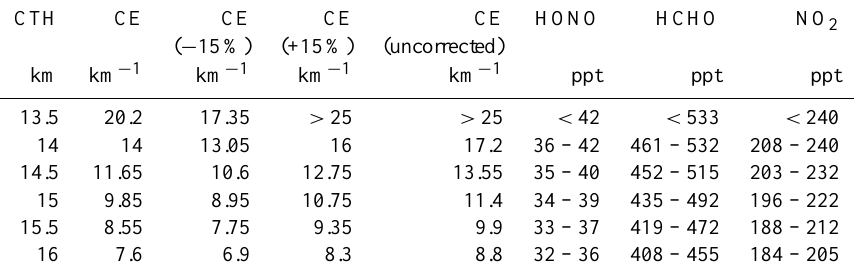
Table 6. Influence of the profile shape on the retrieved mixing ra- tios. For the fourth profile the constant NO 2 mixing ratio below 6km is given. Profile shape HONO HCHO NO 2 [ppt] [ppt] [ppt] Constant mixing ratio (1km...CTH) Constant mixing ratio (8km...CTH)